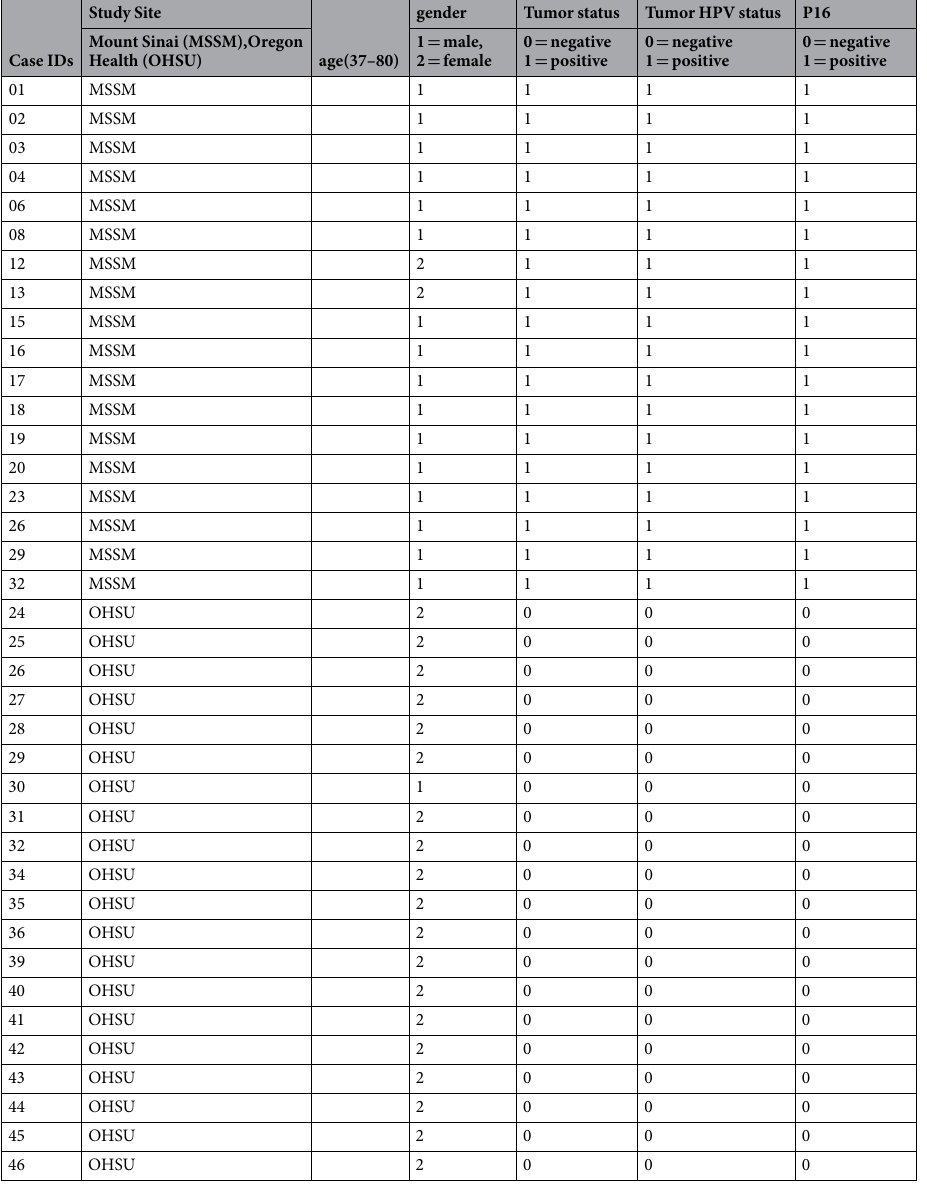
Table 3. Patient